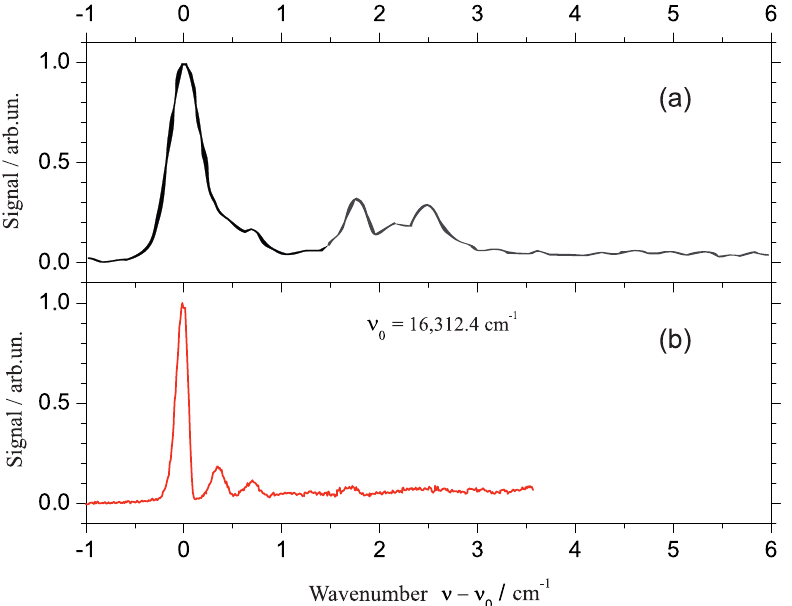
Figure 5. Electronic origin of the fluorescence excitation spectrum of porphyrin in helium droplets once recorded beyond ( a ) and once below ( b ) the saturation